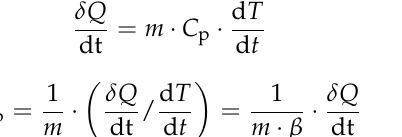
Figure 8. ( a ) Phase transition temperature; ( b ) Phase transition enthalpy.